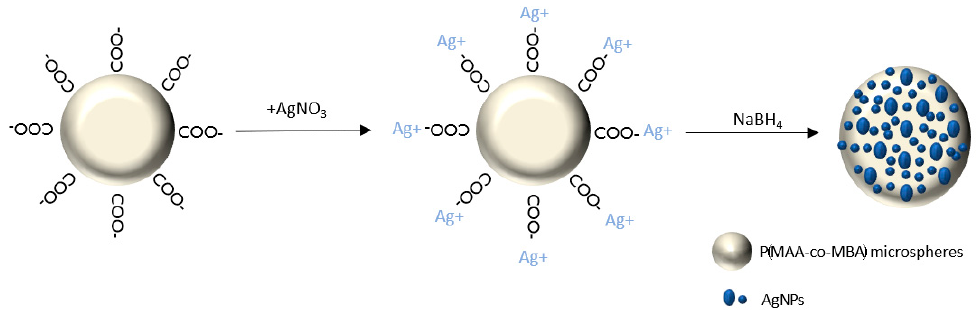
Figure 1. Schematic representation of Ag ion reduction to AgNPs on the surface of P(MAA-co-MBA)